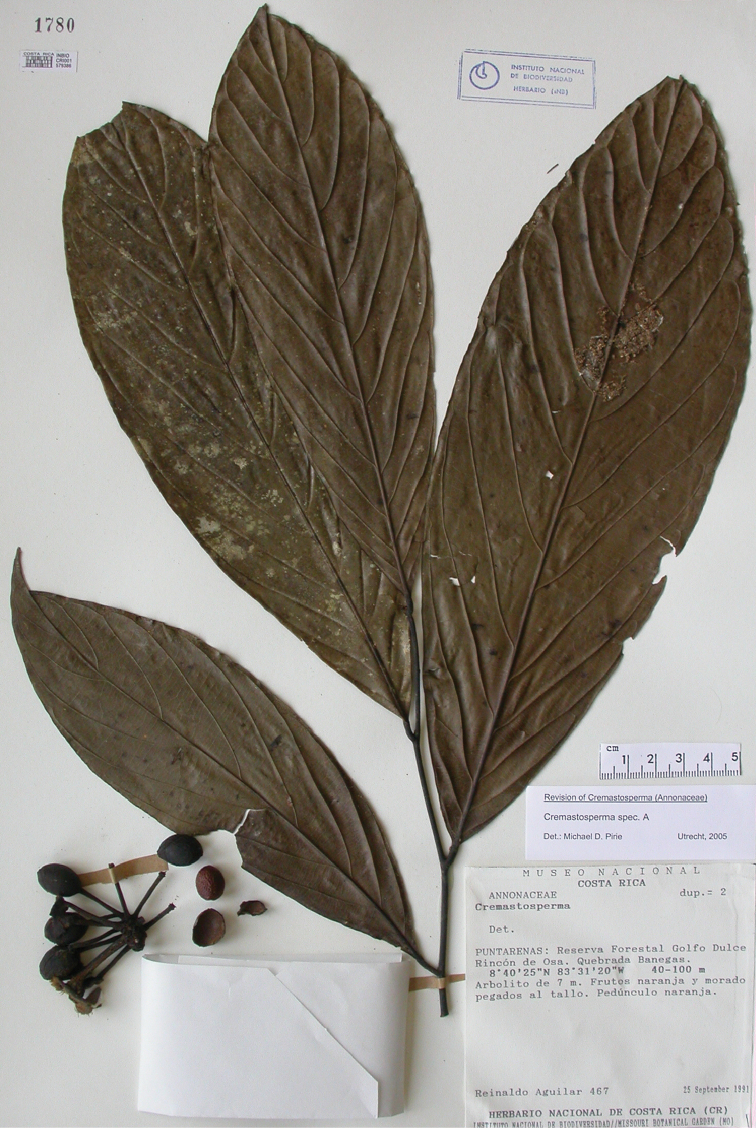
Cremastospermaosicola Pirie & Chatrou fruiting specimen (Aguilar 467).